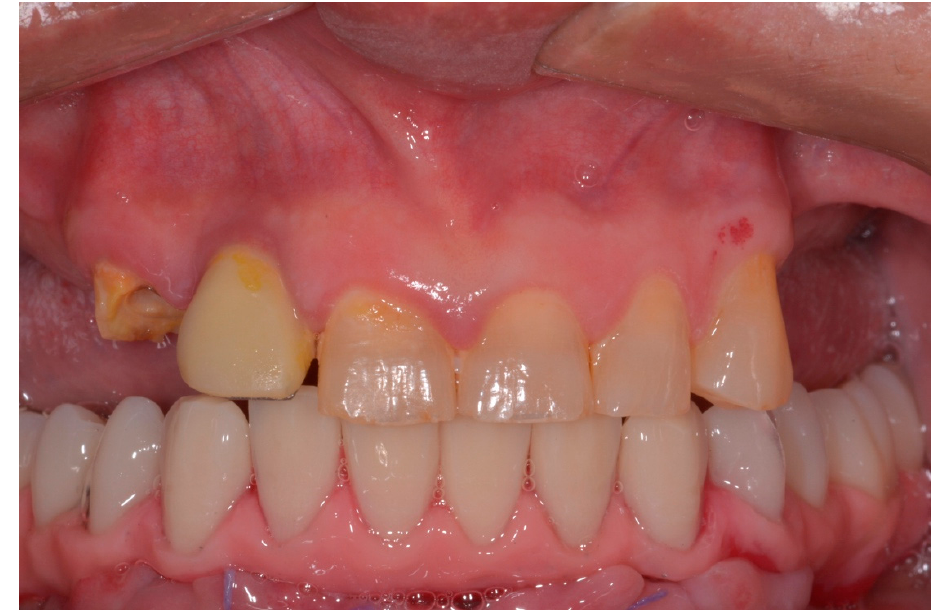
Figure 6. 7 days postoperative control.